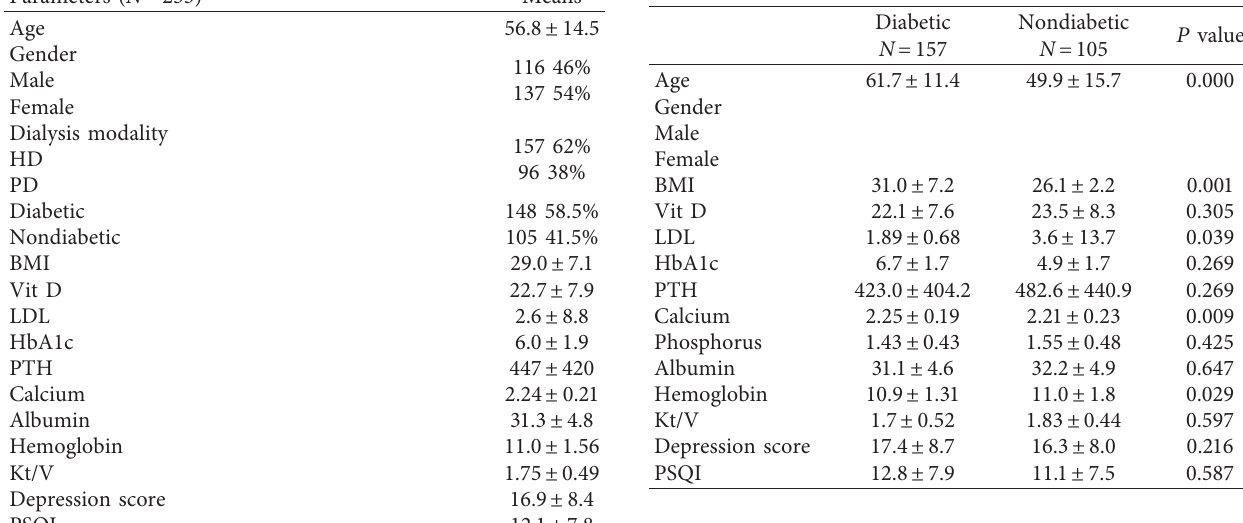
Table 2: Comparison between diabetic and nondiabetic HD pa- tients based on different parameters.